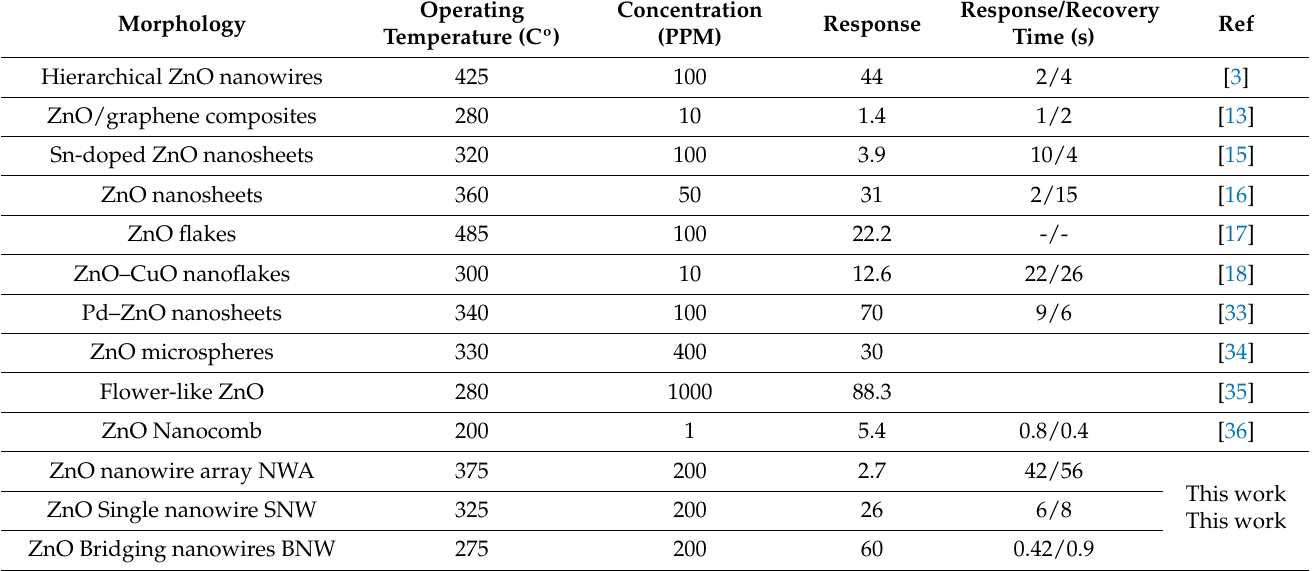
Table 1. A comparison between the fabricated ZnO nanostructure acetone gas sensors in this work and some of the reported sensors in the